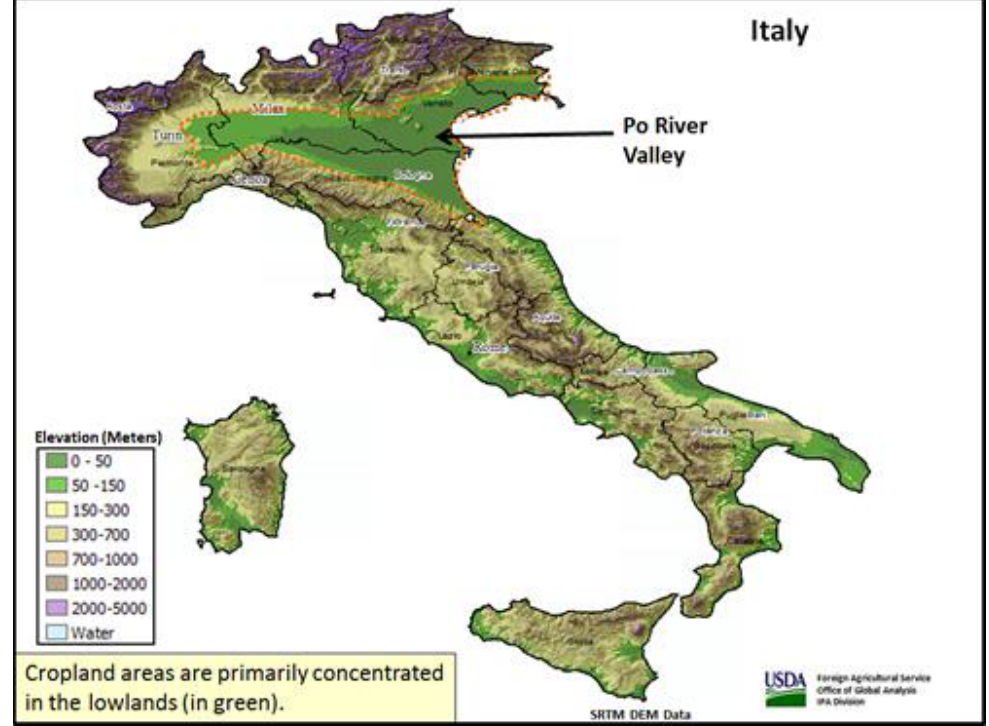
Figure 2. Map of Cropland Areas in Italy [58].